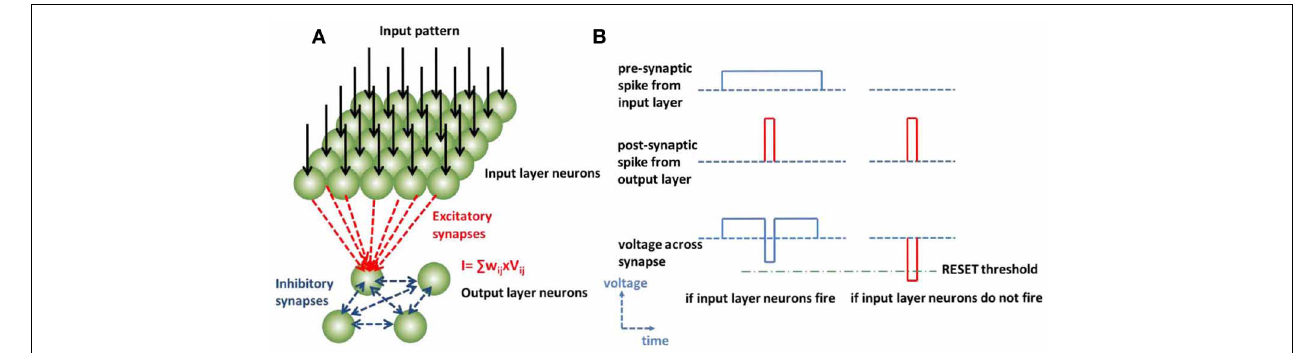
FIGURE A2 | The spiking scheme for the analog synapse utilizing the depression-only learning.